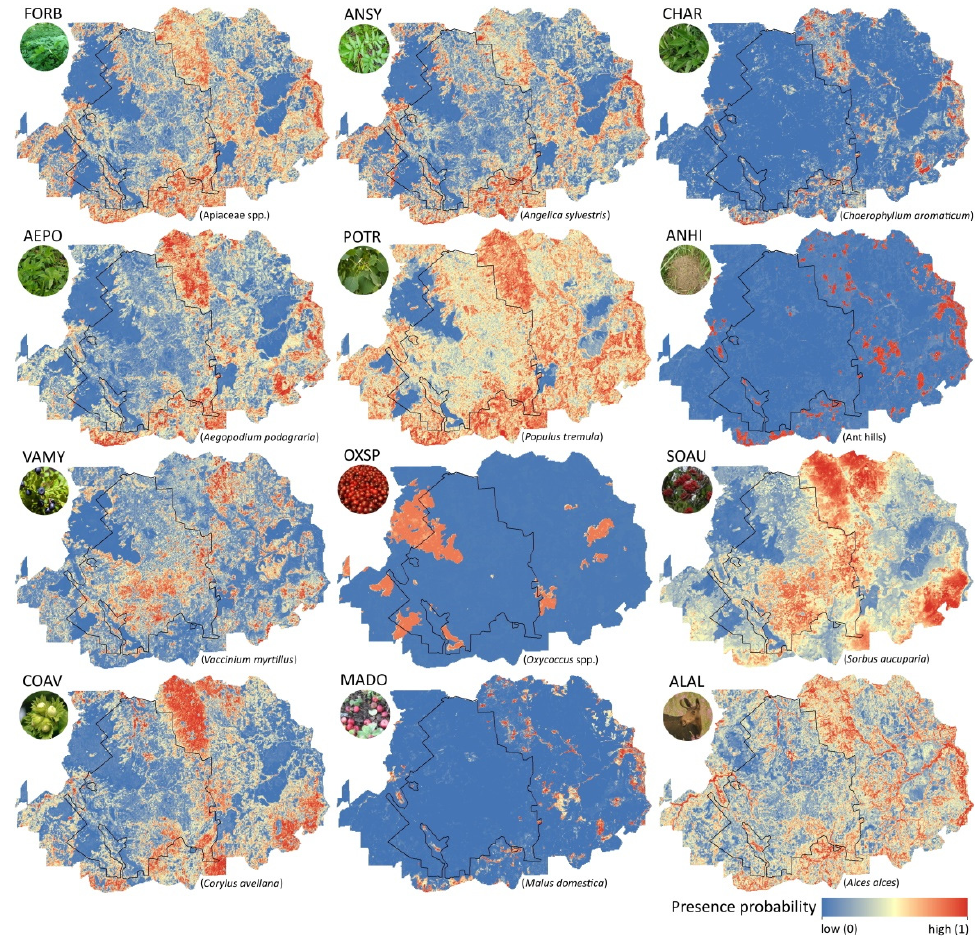
Figure 5. Presence probability maps for 12 brown bear food-probability models in the Central Forest State Nature Reserve and its buffer zone (West-European Russia) in 2008–2020. Models presented are FORB ( Apiaceae spp.), ANSY ( Angelica sylvestris ), CHAR ( Chaerophyllym aromaticum ), AEPO ( Aegopodium podagraria ), POTR ( Populus tremula ), ANHI (ant hills), VAMY ( Vaccinium myrtillus ), OXSP ( Oxycoccus spp.), SOAU ( Sorbus aucuparia ), COAV ( Corylus avellana ), MADO ( Malus domestica ), ALAL ( Alces alces ). The CFNR core area is inside the black line polygon; the CFNR buffer zone is outside the black line polygon.